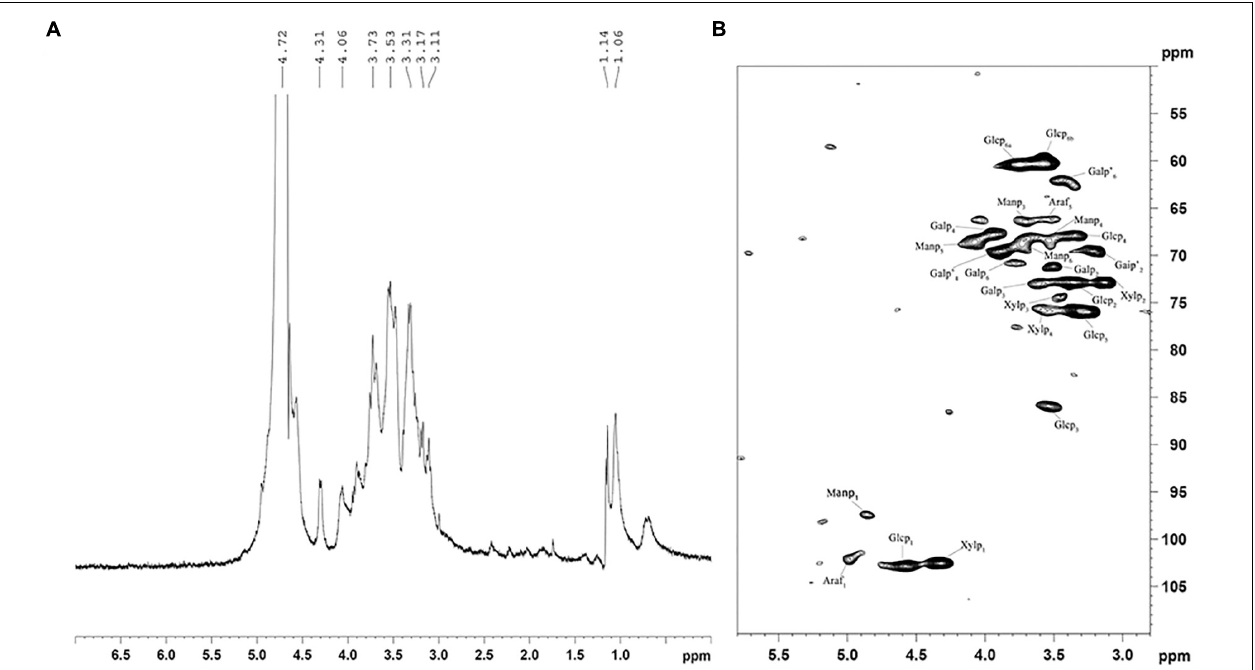
HRP is composed of glucose (the predominant component), mannose, galactose, glucuronic acid, xylose, and arabinose, in molar ratio 49.00: 17.78: 12.93: 10.99: 8.59: 0.71% ( Table 1 ).